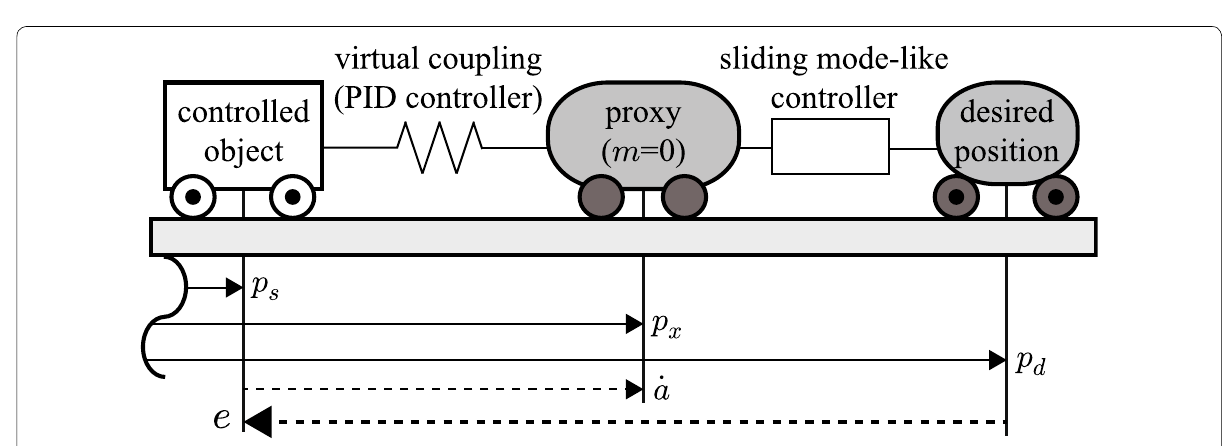
Fig. 2 Physical interpretation of PSMC and